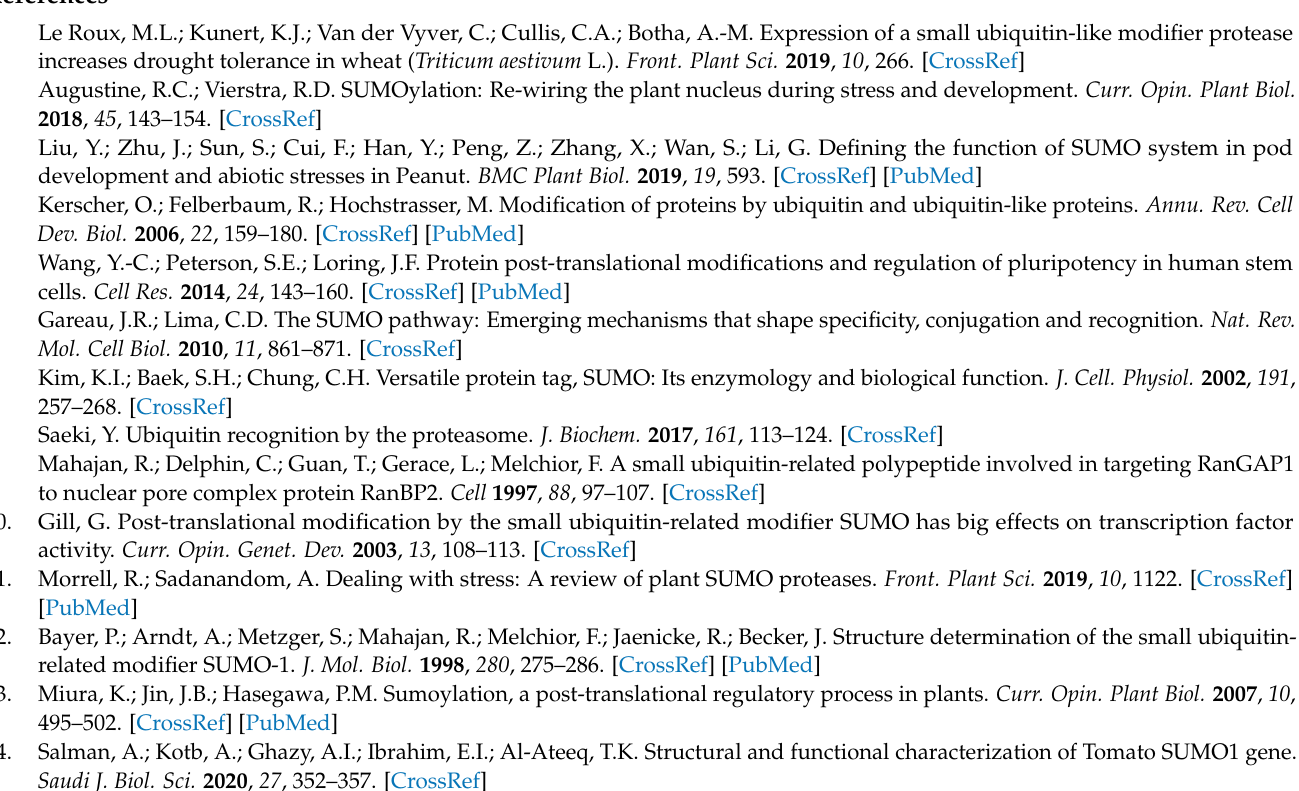
Table S2. OsSUMO and AtSUMO amino acid and atomic composition. Table S3. OsSUMO and AtSUMO composition of amino acid by percentage. Figure S1: (A) Construction of expression plasmid harboring OsSUMO7 gene. (B) Construction of expression plasmid harboring OsSUMO7 gene with GG deletion. (C) Construction of expression plasmid harboring SCE1a gene. (D) Construction of expression plasmid PTS2:GFP. (E) Construction of expression plasmid mt:GFP. (F) Construction of expression plasmid WxTP:GFP. (G) Construction of expression plasmid